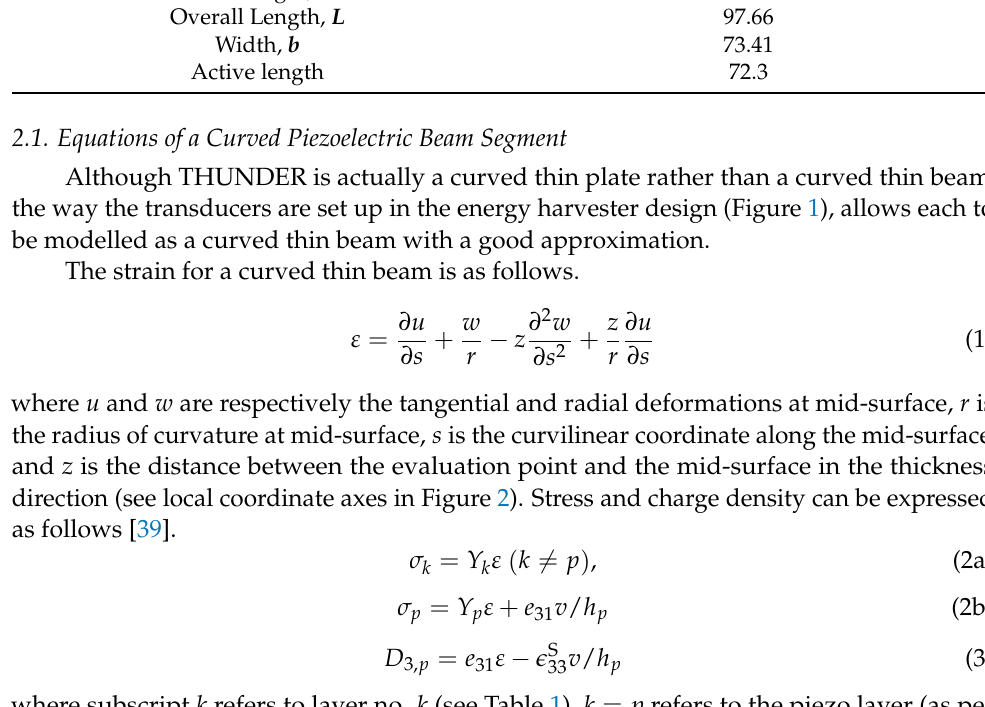
Table 2. Dimensions used for THUNDER (all properties are given in mm).